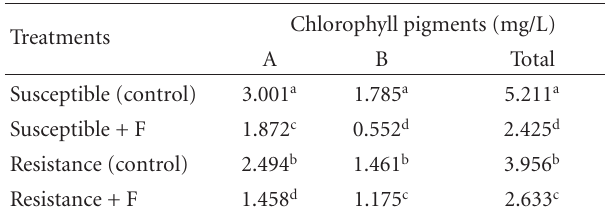
Table 2: Chlorophyll contents in susceptible and resistant biotypes of E. crus-galli after 14 days of treatment with fenoxaprop-p-ethyl compared with untreated